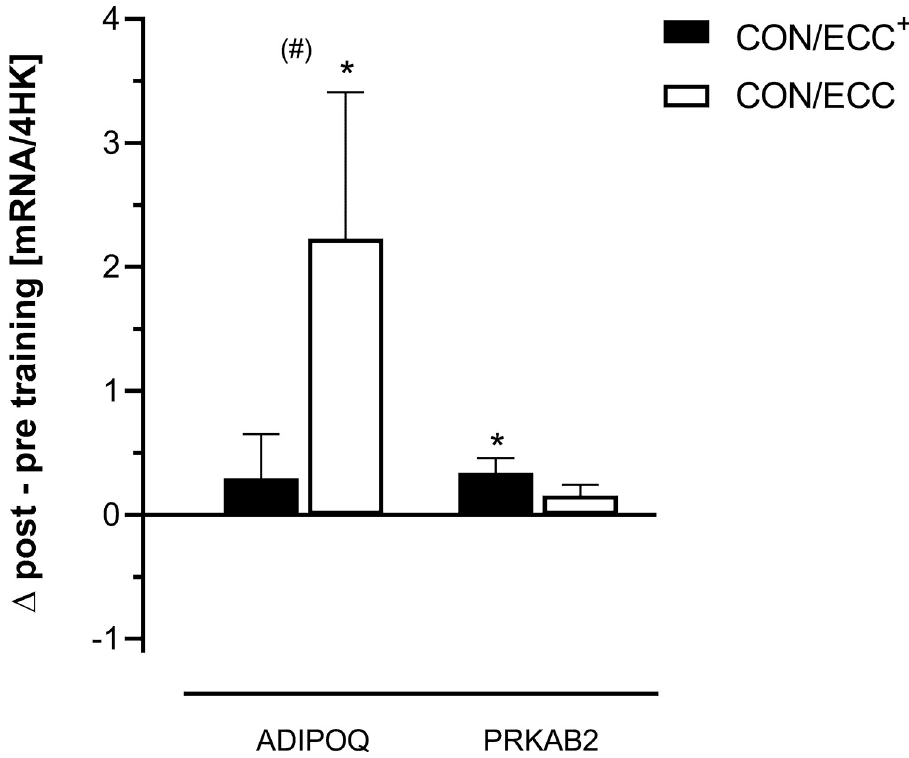
Fig 4. Significantly changed marker mRNAs encoded by genes involved in skeletal muscle autocrine signaling and/or energy-sensing. These are relative values based on an aggregate of 4 housekeeping (HK) transcripts. Mean ± SE are shown. (#): Tendency (p = 0.052) towards a group x time effect; � : p < 0.05, �� : p < 0.01 compared to the respective baseline